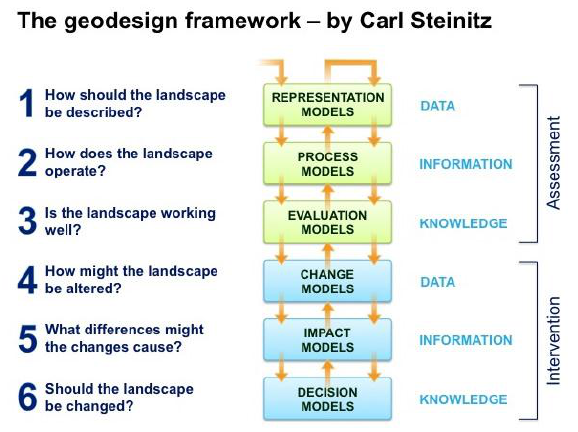
Figure 3 The geodesign framework conceived by Carl Steinitz (Steinitz, 1979).